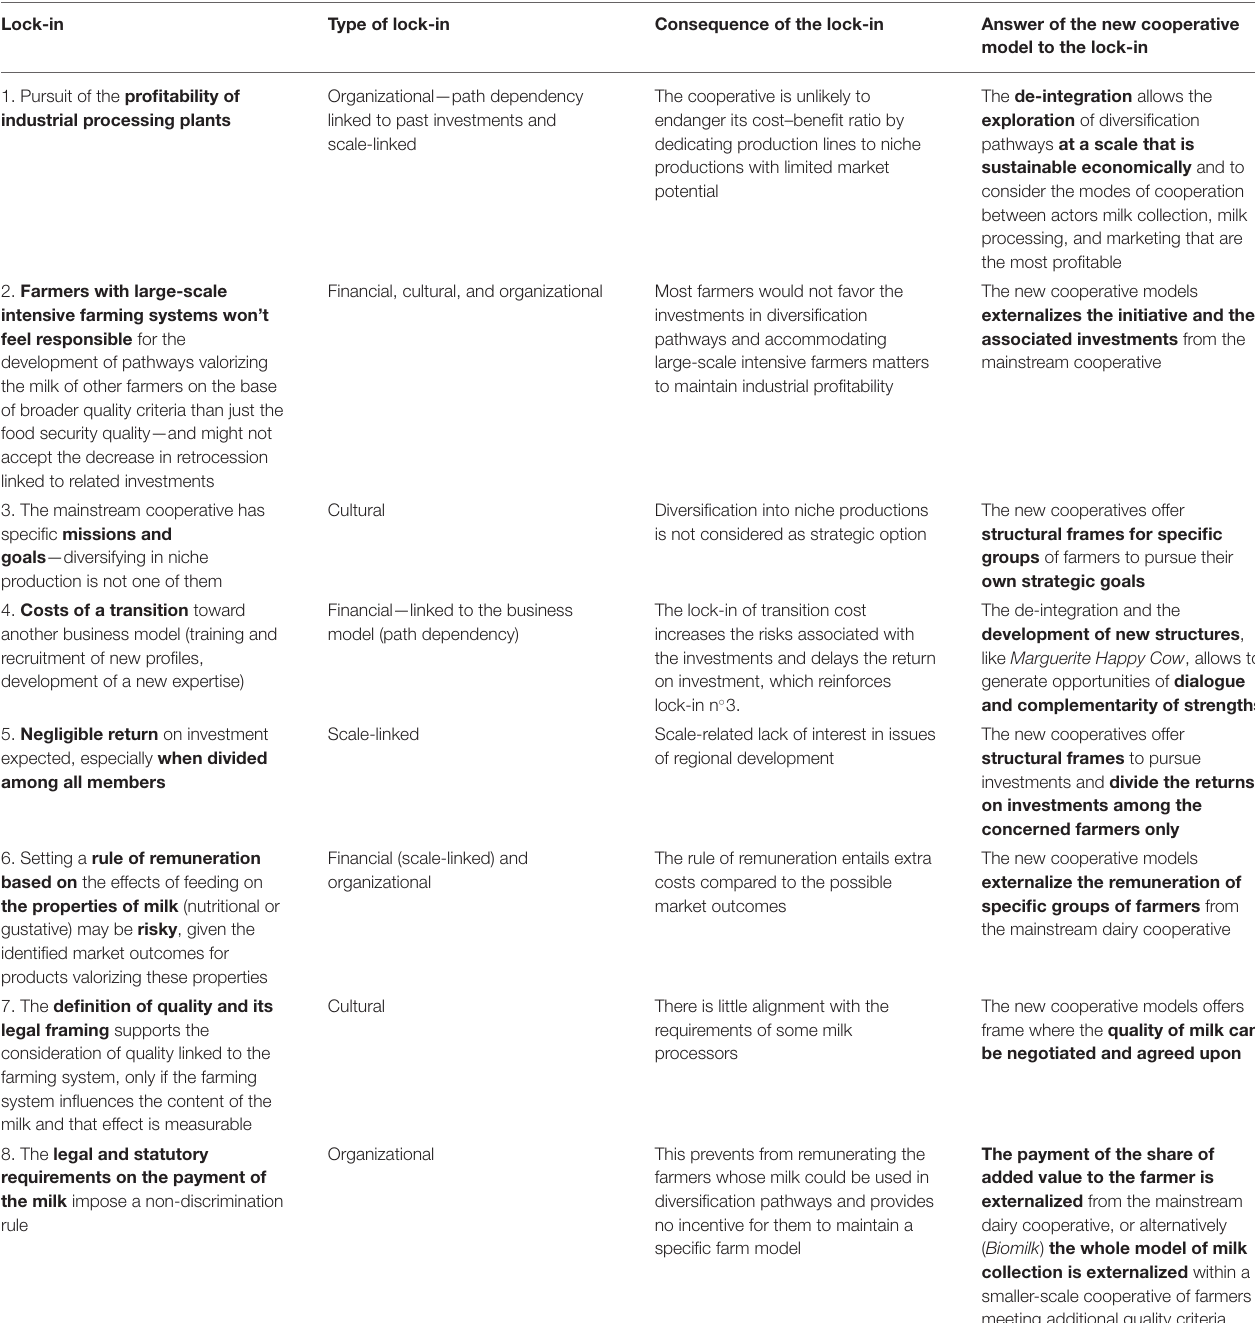
TABLE 6 | Lock-ins preventing mainstream dairy cooperatives to explore diversification pathways and answers provided by the new cooperative models.